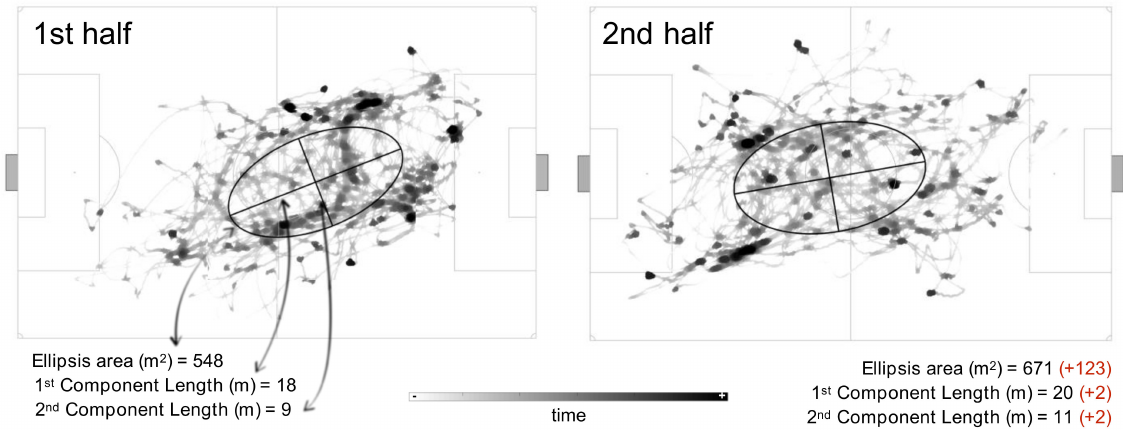
Figure 2. Referee diagonal movement. The grey heat map represents the referee position density (darker areas represent more time spent), and the ellipse shows the referee position variability during each half (computed by the principal component analysis).